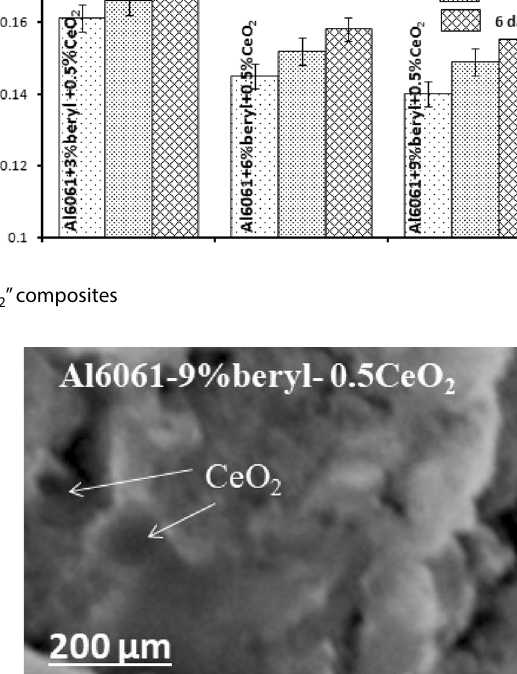
Fig. 13 Microscopic image after exposure in 3.5% HCl solution for 6